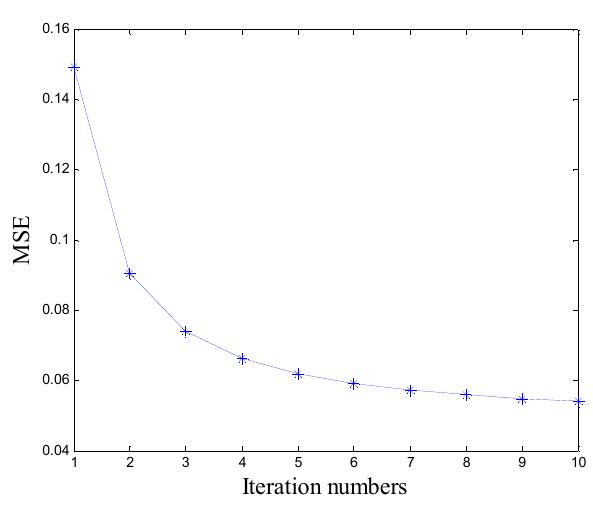
Figure 19. Cm values along with iterations.